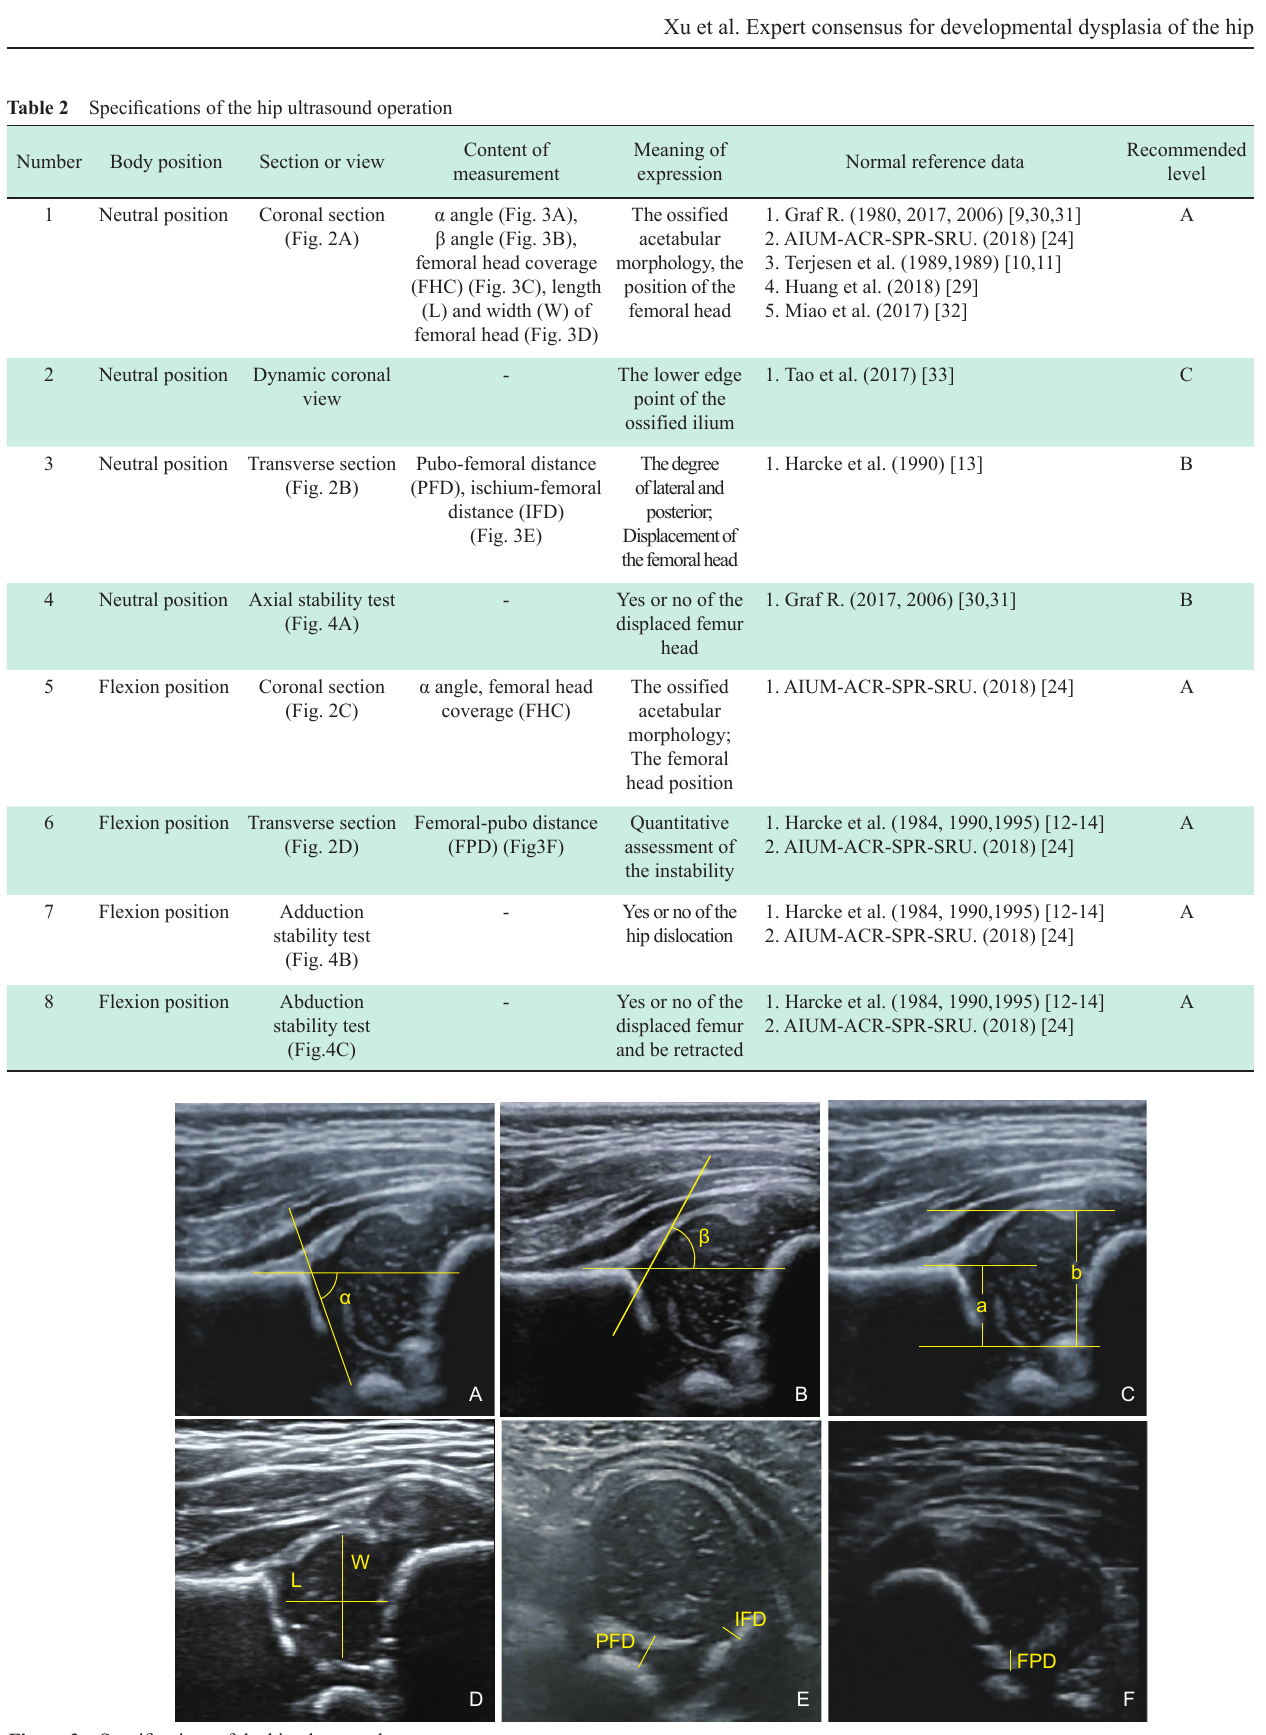
Figure 3 Specifications of the hip ultrasound measurements (A) Alpha angle; (B) β angle; (C) Femoral head coverage ((b-a)/b); (D) Femoral head size, Length (L), Width (W); (E) Pubo-femoral distance (PFD) and ischium-femoral distance (IFD); (F) Femoral-pubo distance